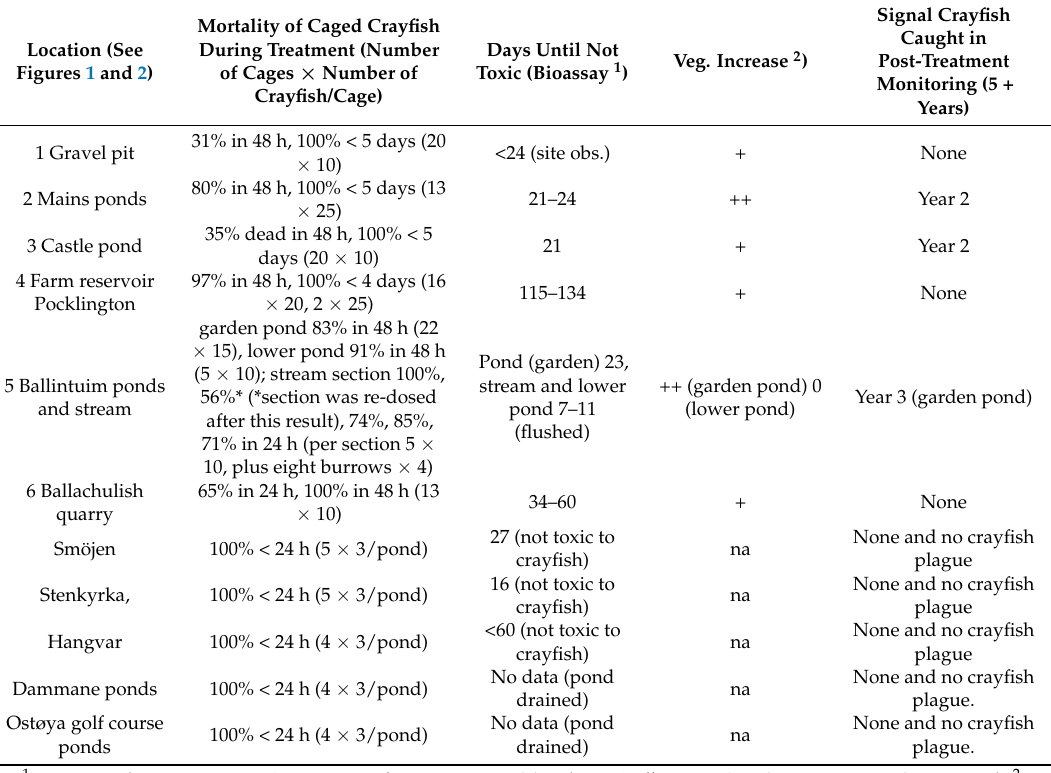
Table 6. The results of biocide treatments against signal crayfish, initial and final